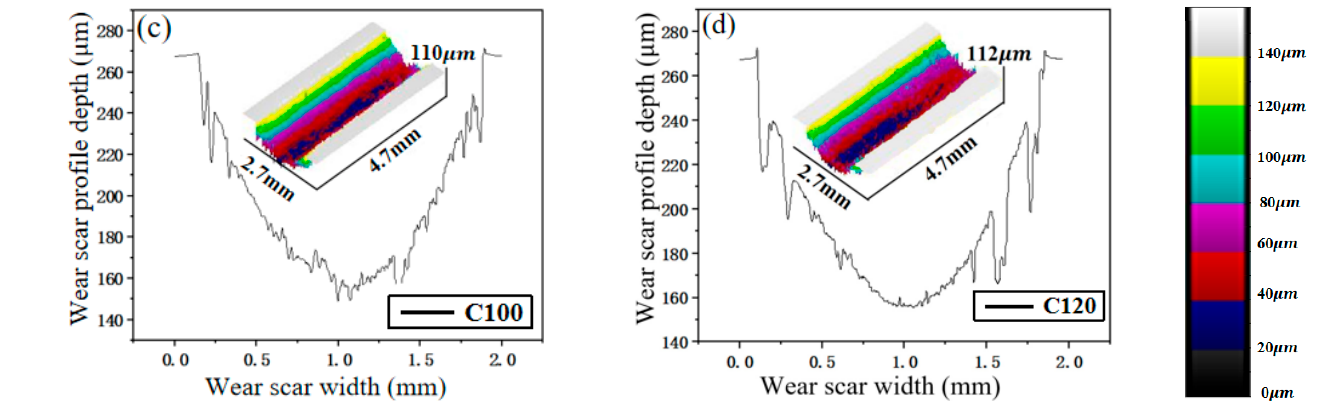
Figure 11. Three-dimensional morphology and cross-section curve of the wear surface after EBSA treatment at different scanning speeds: ( a ) BM, ( b ) C80, ( c ) C100, ( d ) C120.